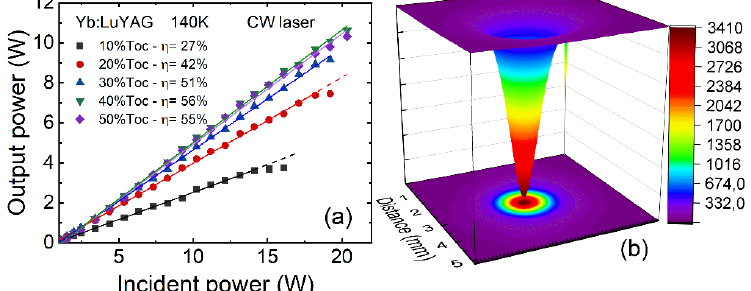
Fig. 1 . CW cryogenic diode-pumped Yb:YLuAG laser: (a) input-output power characteristics for different transmissions of the output coupler ( T OC ), η – slope efficiency, T = 140 K; (b) a typical far-field beam profile at the maximum output power. Continuous-wave (CW) laser operation was realized initially at different temperatures in the range of 80 - 280 K with a step of 20 K using the same output coupler transmission ( T OC = 20%). As a result, we determined an optimum crystal temperature of 140 K for efficient laser operation, see Fig. 1(a) for the input-output dependences. The cryogenic diode-pumped Yb:YLuAG laser generated a maximum CW output power of 10.65 W at 1029 nm with a slope efficiency of 56% (with respect to the incident pump power) for T OC = 40%. Figure 1(b) shows the far- field beam profile measured at the maximum output power corresponding to the fundamental transverse mode., In the passively Q-switched regime, using the SA with the initial transmission of 85%, the pulse energy / duration were 0.15 mJ / 201 ns at a repetition rate of 19.22